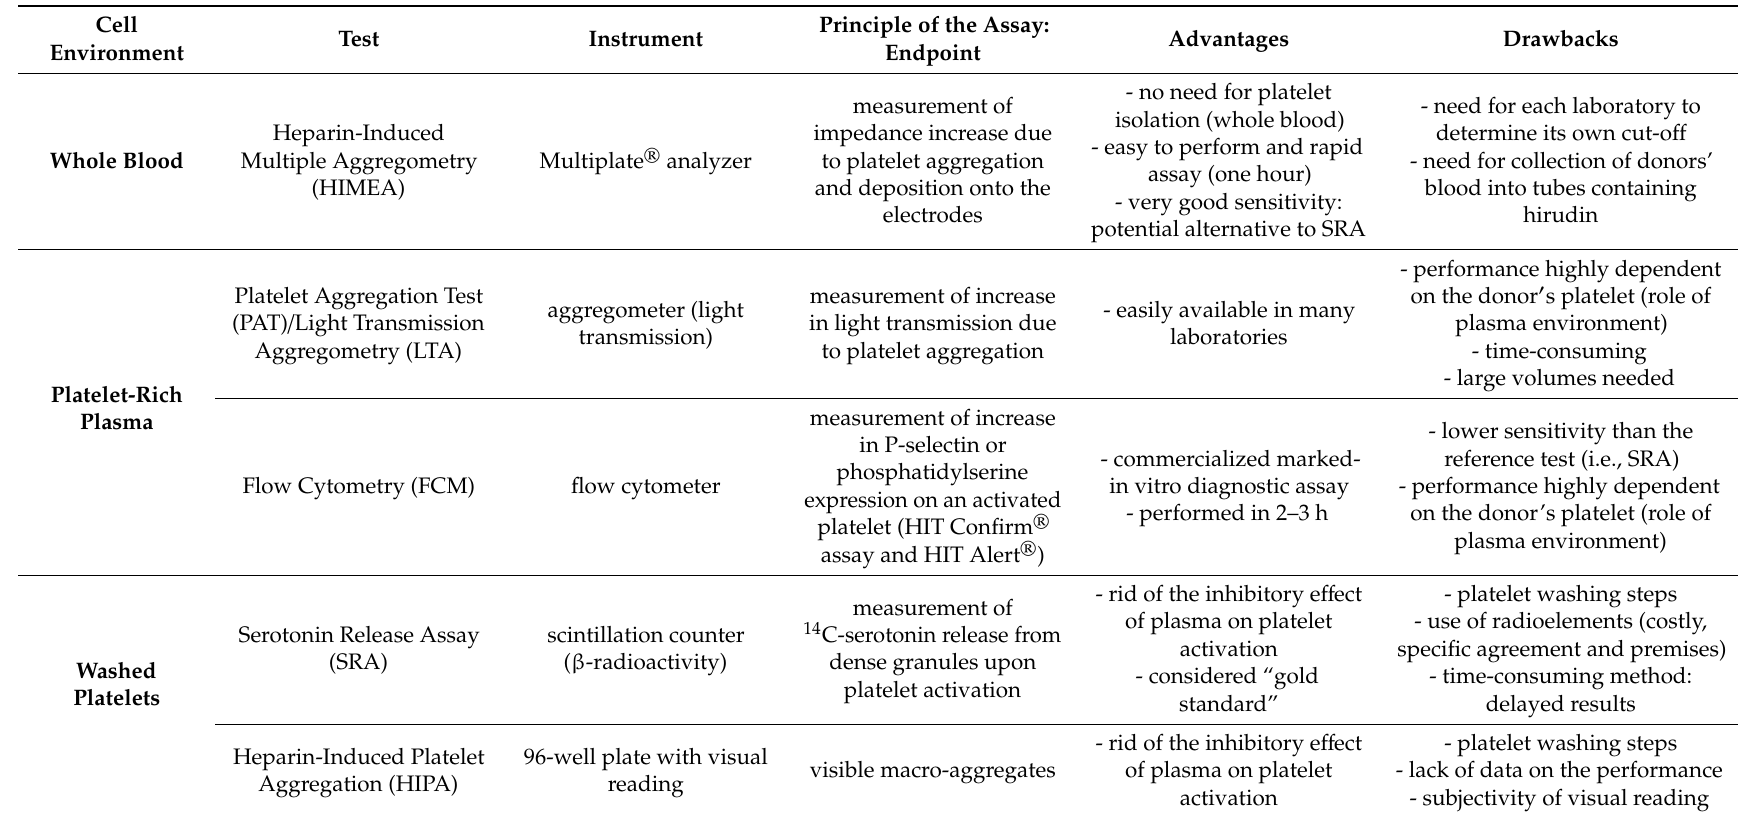
Table 1. Methodologies, advantages, and drawbacks of functional